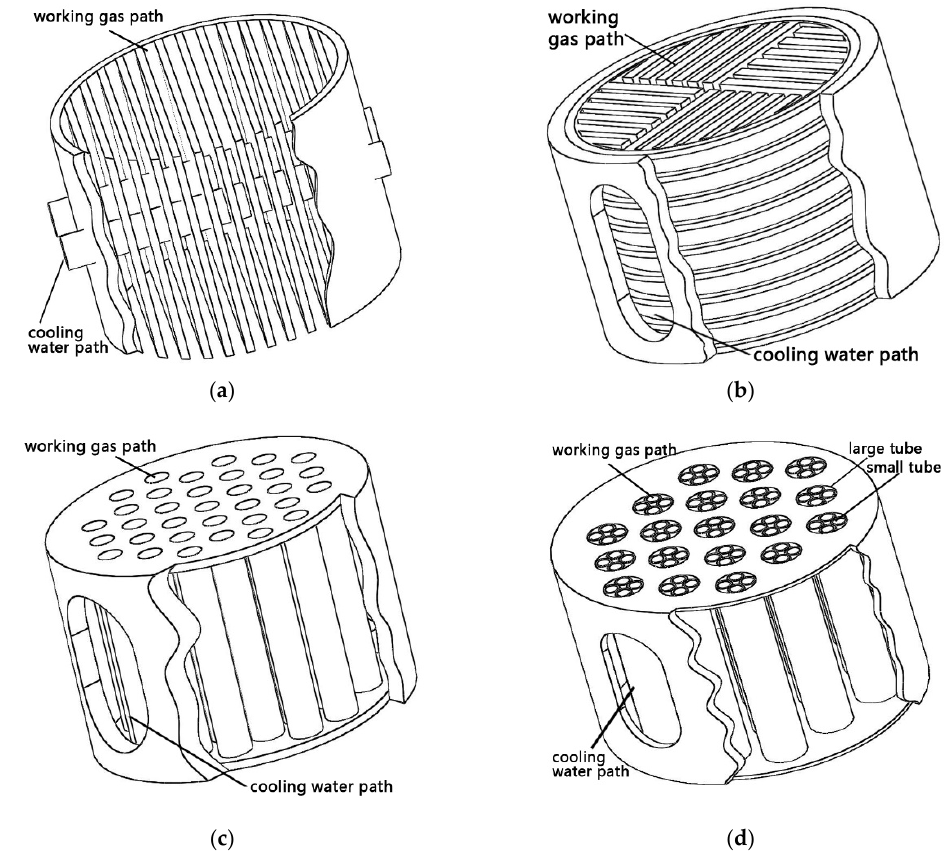
Figure 1. Four configurations of WHCXs. ( a ) Finned-tube type; ( b ) WEDM machined type which can